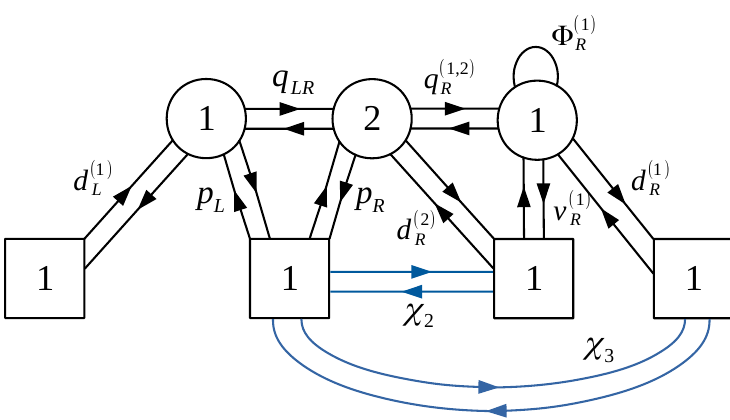
Figure 13 . Quiver diagram after the application of Aharony duality on the middle node. This coincides with the one of (cid:12)gure 9 predicted by the recombination duality in the case N = 3 and k =